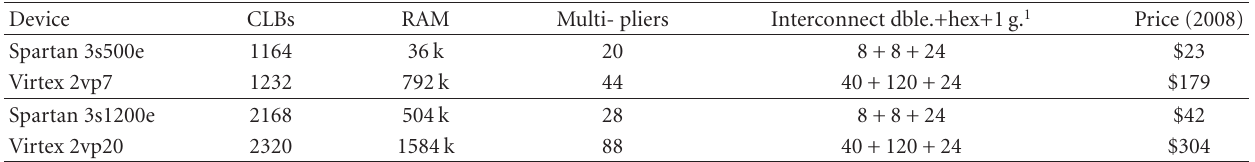
Table 1: Features and prices of two xilinx FPGA families (spartan: low-cost and virtex: resource-rich).